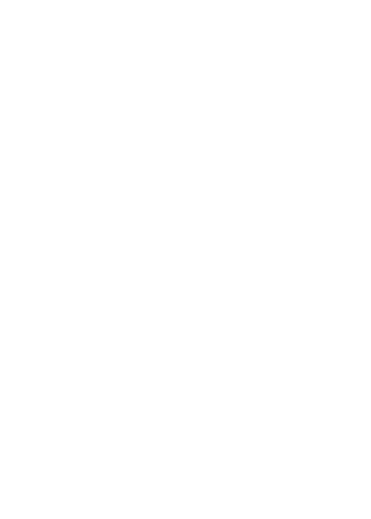
Table 1. Clinical parameters contained in